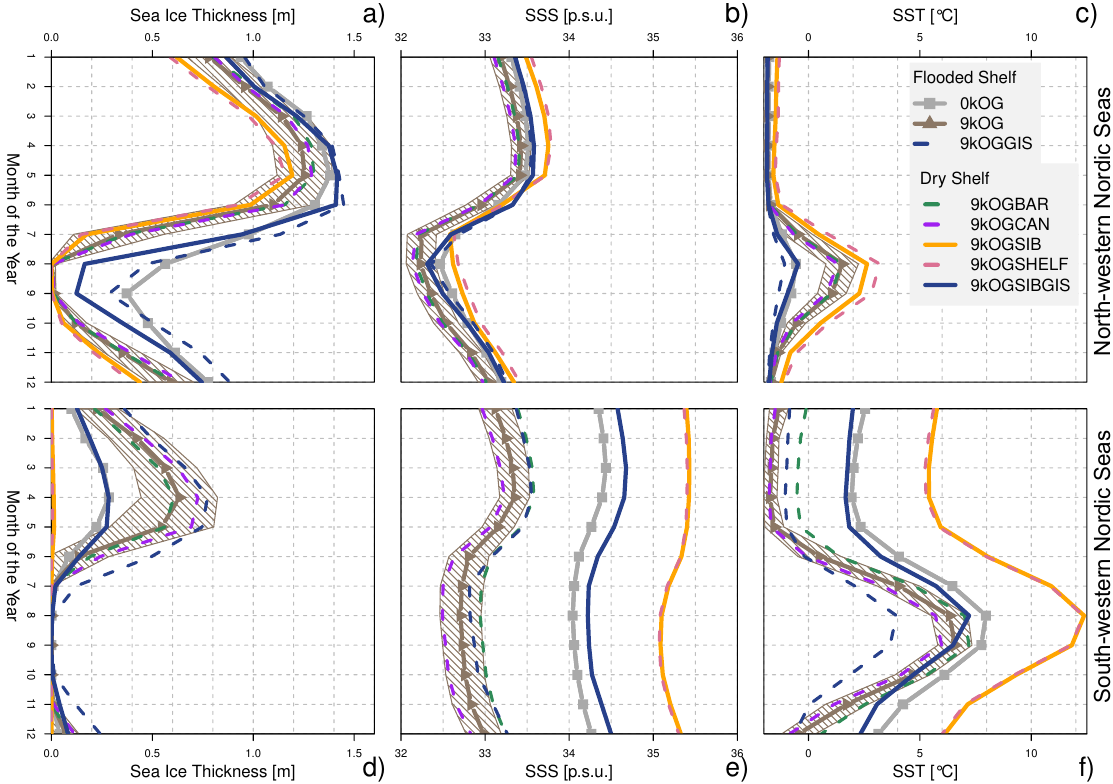
Fig. 5. Monthly means of the last 100yr of each simulation for the north-western Nordic Seas (20–15 ◦ W, 73.75–81.25 ◦ N) in the upper panel and for the south-western Nordic Seas (47.5–22.5 ◦ W, 68.75–71.25 ◦ N) as denoted in Fig. 1 blue boxes. ( a/d ) sea-ice thickness in metres, ( b/e ) sea surface salinities (SSS) in p.s.u., ( c/f ) sea surface temperatures in degree Celsius. Shaded areas give an estimation of the standard deviation of the monthly means for simulation 9kOG.